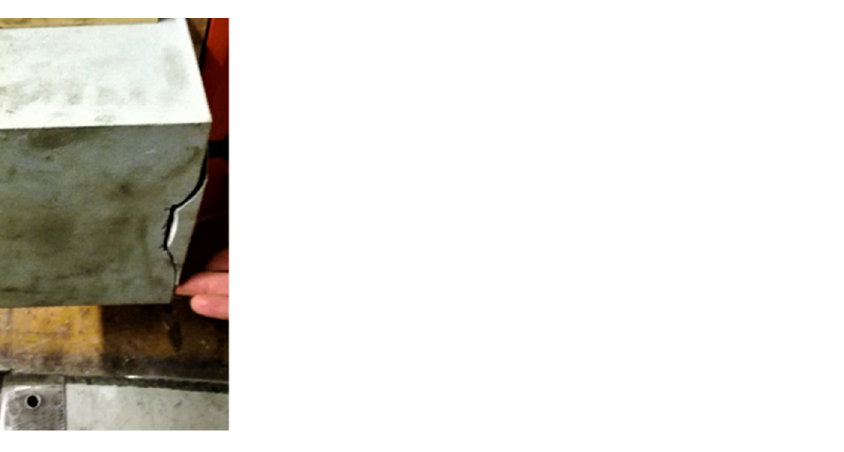
Figure 10. A view of the sandstone block after the miningwith disk tools 150 mm in diameter and edge angle 40°.